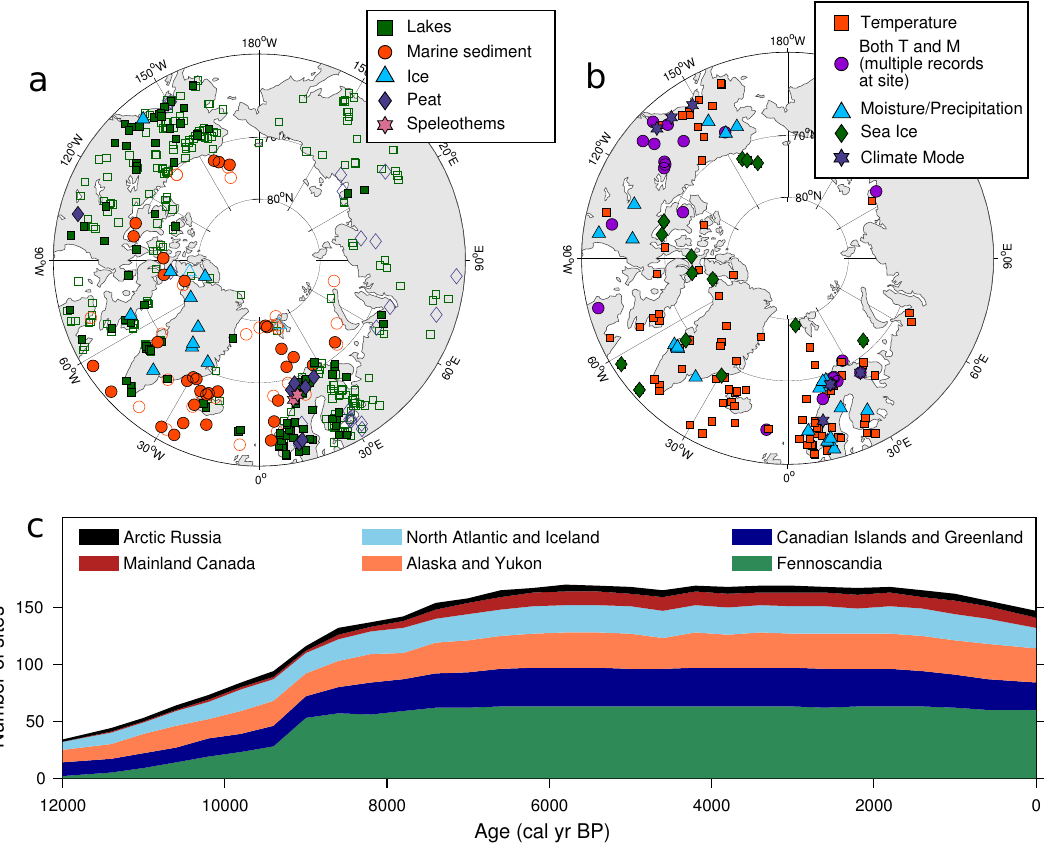
Figure 2. Location of proxy records in this database. ( a ) Sites that meet the criteria for inclusion in this database (solid symbols) and those that did not (open symbols) plotted by material/archive type. ( b ) Sites that meet the criteria plotted by broadly categorized climate variables ( T and M : temperature and moisture variables of all types, respectively). ( c ) Number of sites showing the time period they cover and subdivided by region. Some sites have more than one time series representing different climate variables. Information about each site is listed in Table 1 (accepted records) and Supplement Table S1 (excluded